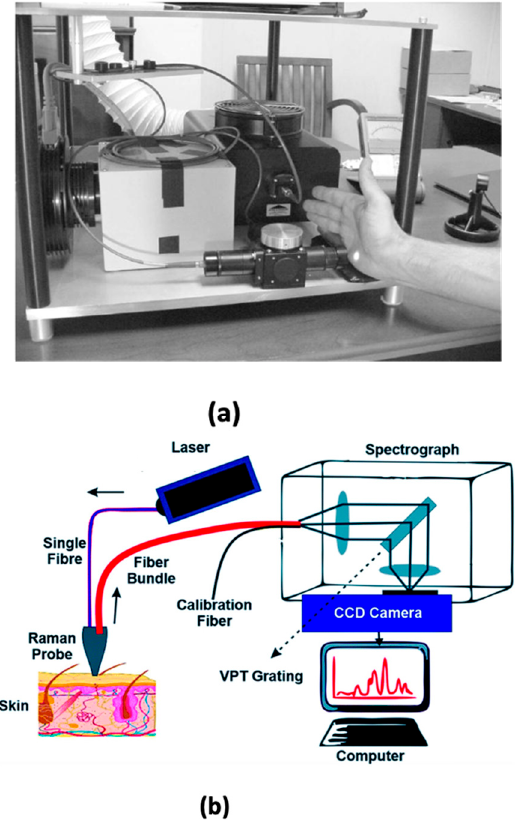
Figure 5. ( a ) Raman spectroscopic detector showing the argon ion laser, spectrograph, light de- livery/collection module and excitation laser spot on the palm of a subject (Reprinted under the Creative Commons Licence from Ref. [119]. 2022, MDPI). ( b ) Diagrammatic description of the Raman spectroscopic detector on a skin surface